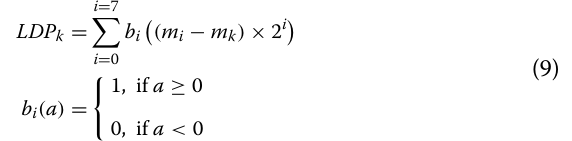
The absolute values of the directional responses are arranged in descending order. For k = 3 significant